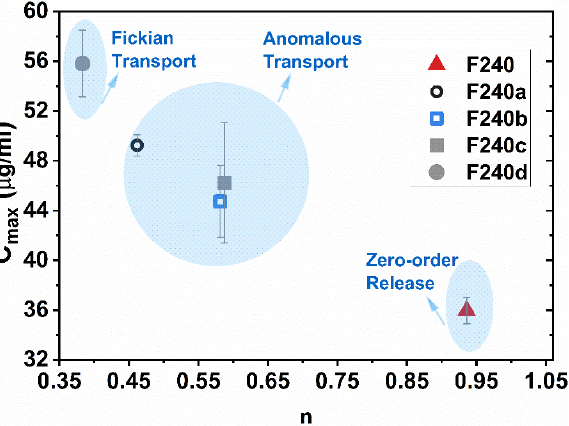
Figure 7. The maximum GF supersaturating concentration for the drug release from FDM 3D tablets within 12 h, as a function of the release exponent, n , of Equation (2).